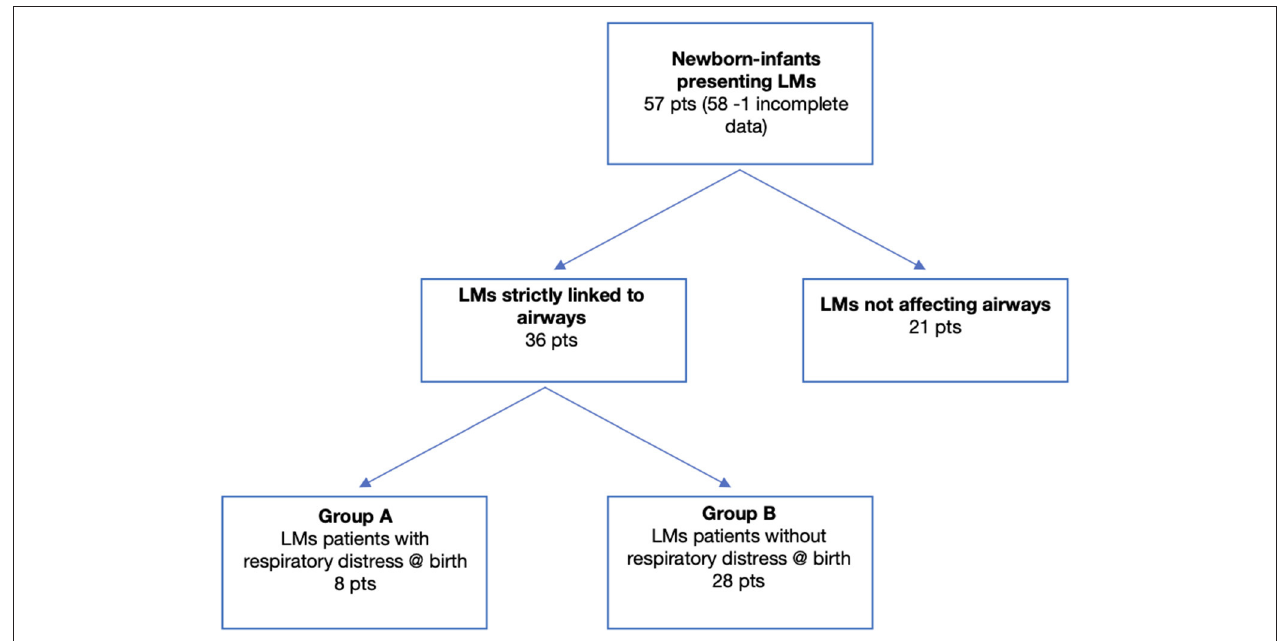
FIGURE 2 | Consort